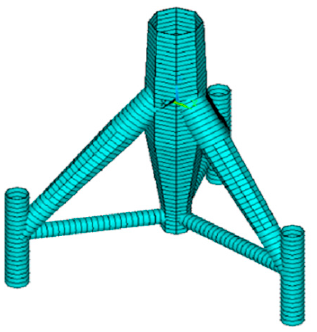
Figure 6. Finite-element model of the tripod